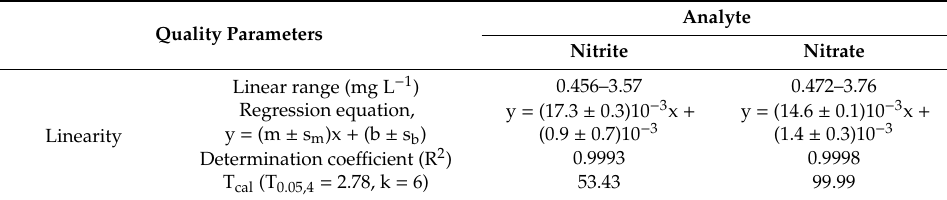
Table 1. Quality parameters of the IC-CD method validated for nitrite and nitrate determination: linearity (m, s m , b and s b are the slope, the standard error of regression slope, the intercept and the standard error of regression intercept, respectively), precision expressed as percent relative standard deviation (%RSD), trueness evaluated as percentage recovery (%R), limit of detection (LOD), limit of quantification (LOQ), and uncertainty